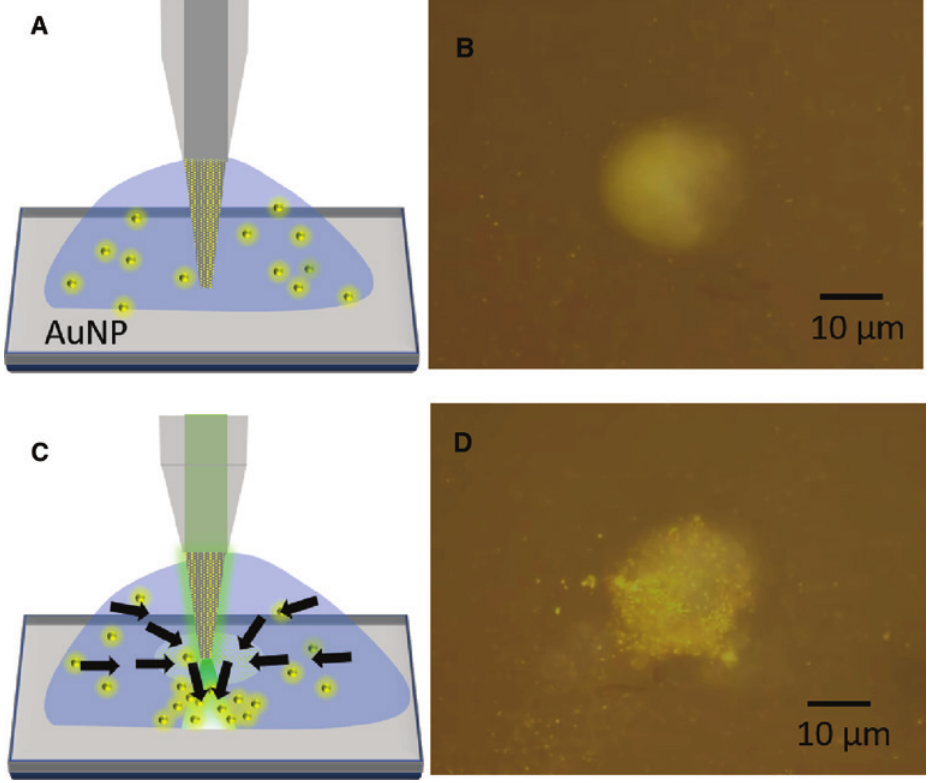
Figure 3: OTFT nanoparticle